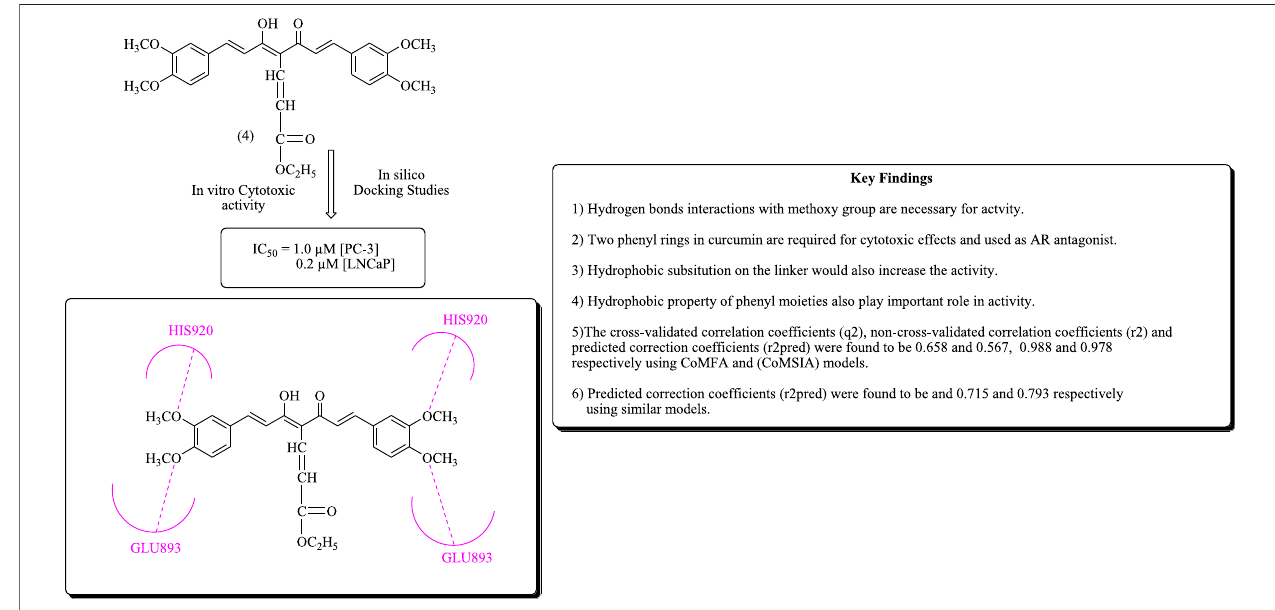
FIGURE 4 | Binding interactions of compound (4) with amino acid residues along with important key fi ndings.